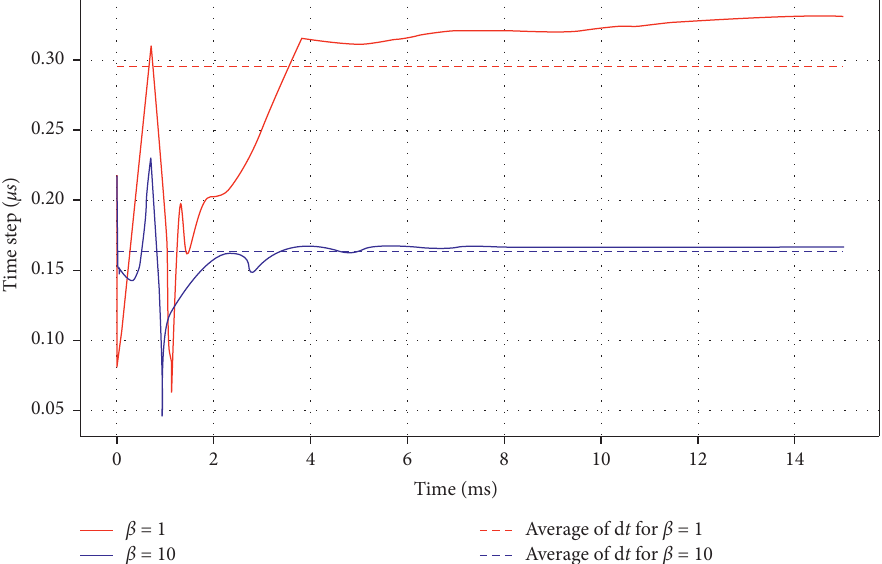
Figure 10: Time step temporal evolution for both β � 1 and β � 10 balloon models. Radial